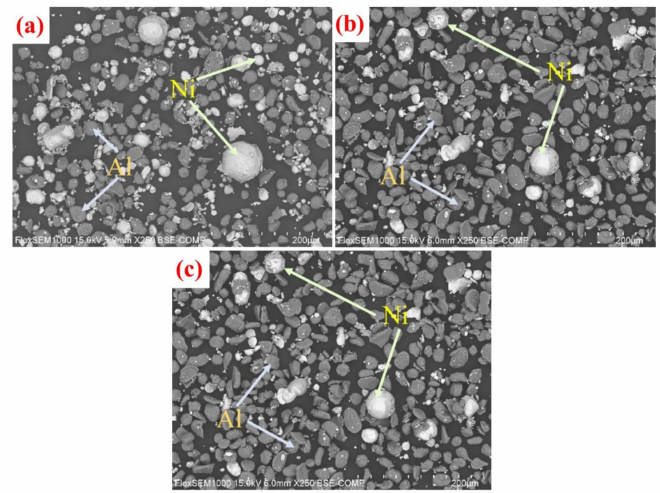
Figure 1. SEM images of ( a ) Ni/Al = 1:1, ( b ) Ni/Al = 1:3, and ( c ) Ni/Al =